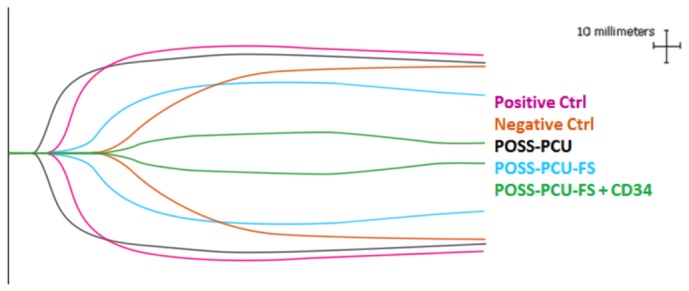
Representative TEG profiles of blood in contact with the modified and unmodified POSS-PCU surfaces.Standard unmodified TEG cups with citrated whole blood were used as positive controls, whereas standard cups containing citrated blood mixed with the anti-coagulant L-arginine were used as negative controls. Profiles demonstrate a similar cigar-shape, indicating functional hemostasis.POSS-PCU-FS: POSS-PCU with fumed silica anchors, POSS-PCU-FS+CD34: POSS-PCU biofunctionalized with anti-CD34 antibodies.